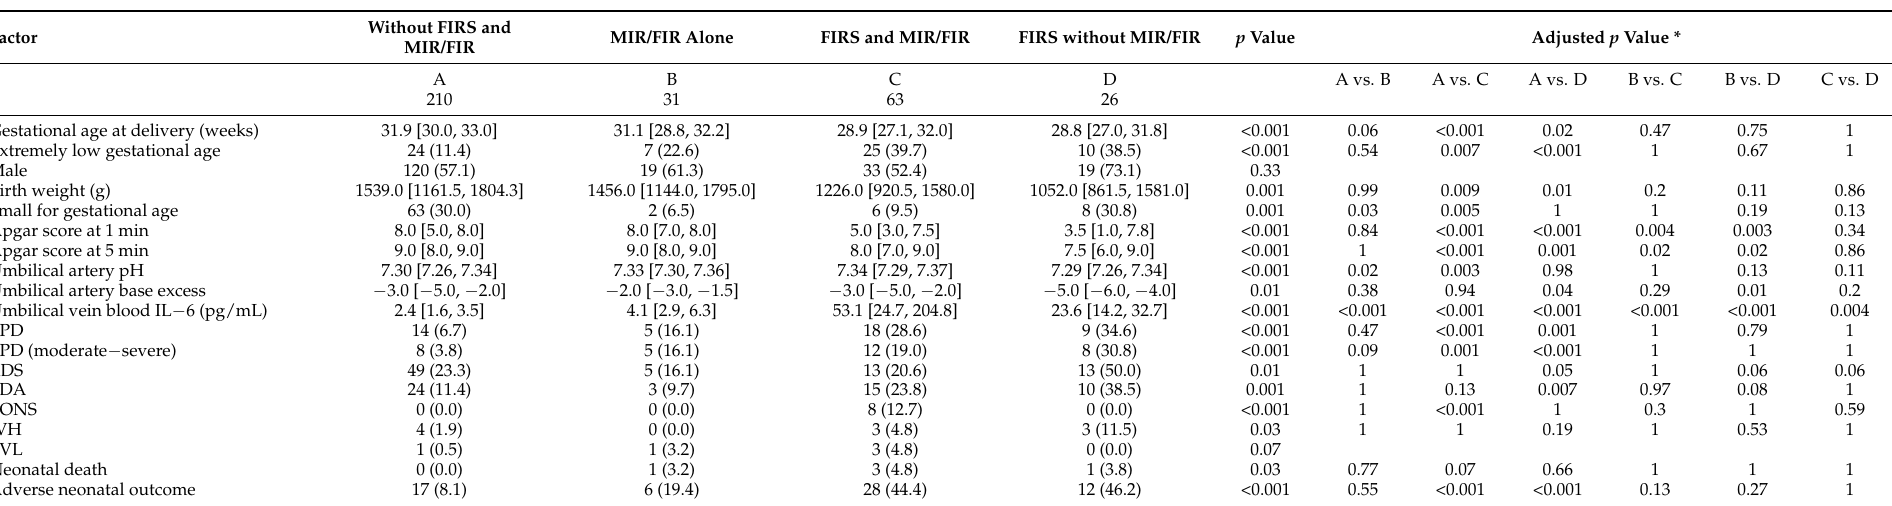
DCH, diffuse chorioamniotic hemosiderosis. Table 2. Perinatal data according to the presence or absence of FIRS and